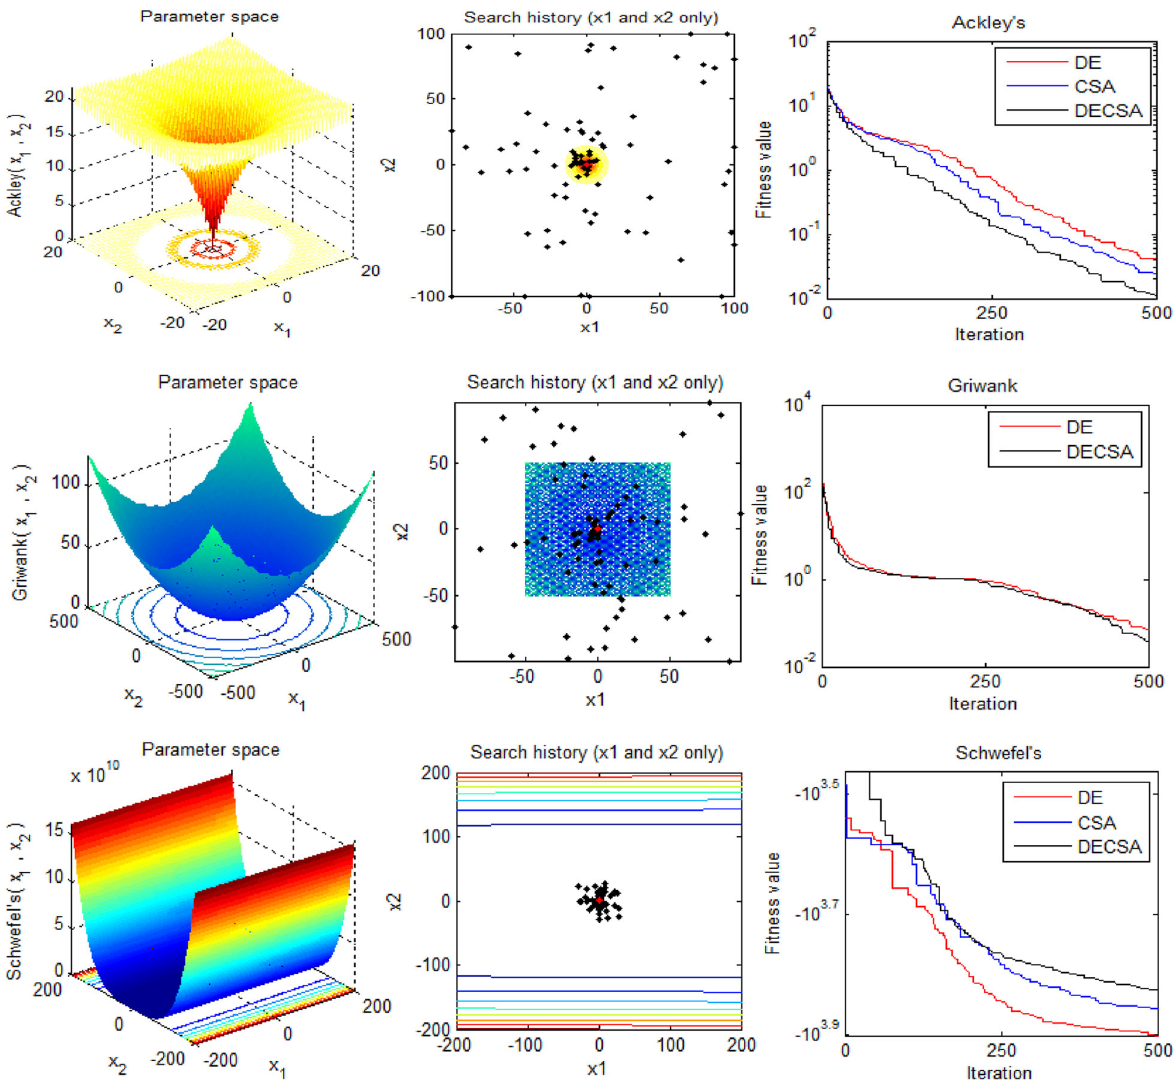
Fig. 4 Convergence characteristics of Multi-modal functions